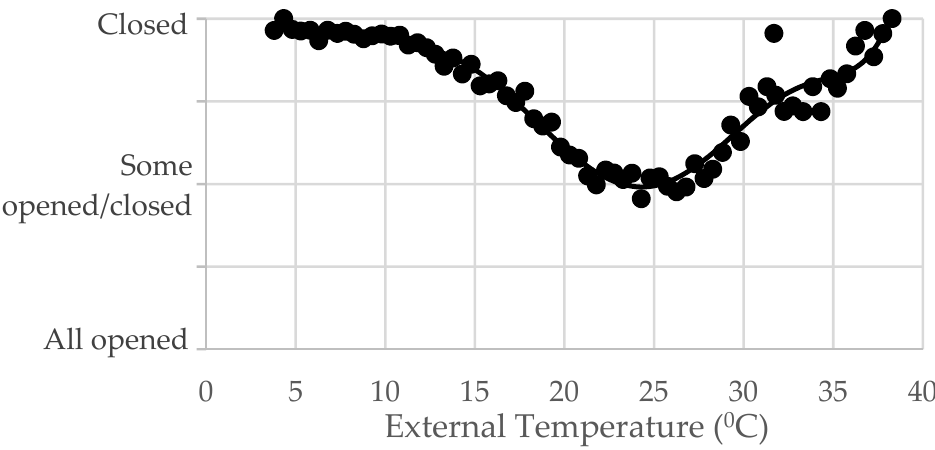
Figure 6. Window condition, as reported by the participants, vs. external temperature.